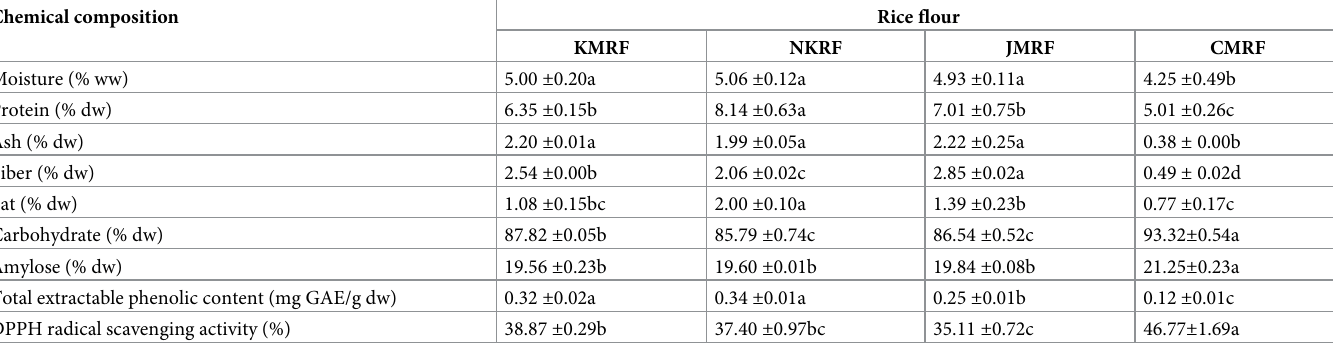
Table 1. Chemical compositions of Thai indigenous brown rice flour, namely brown Khai Mod Rin rice flour (KMRF) and brown Noui Khuea rice flour (NKRF), in comparison with brown Jasmine rice flour (JMRF) and commercial rice flour (CMRF). Chemical composition Rice flour Moisture (% ww) Ash (% dw) Fat (% dw) Carbohydrate (% dw) Amylose (% dw) Total extractable phenolic content (mg GAE/g dw) DPPH radical scavenging activity (%) Values are means ± standard deviation from triplicate determinations. Different letters are significantly different along the rows ( p < 0.05). GAE = gallic acid equivalent, ww = wet weight, dw = dry